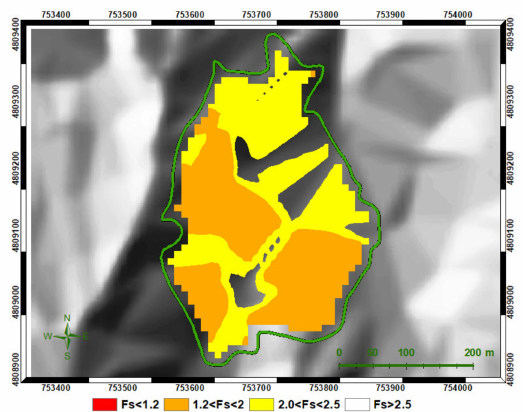
Figure 3. Spatial distribution of Fs evaluated considering the mean deterministic values defined in Table 1 for the physical and mechanical properties of the soil. The green polygon denotes the landslide